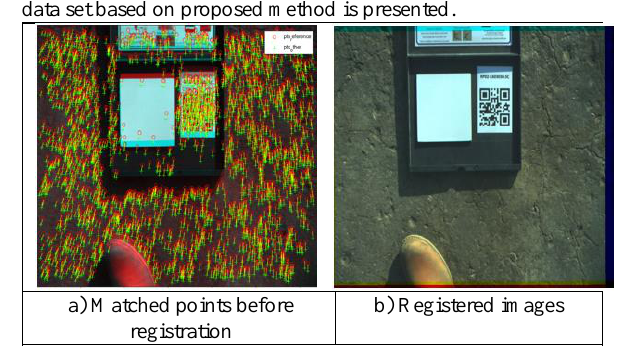
Figure 11. Matching and registration, data set1